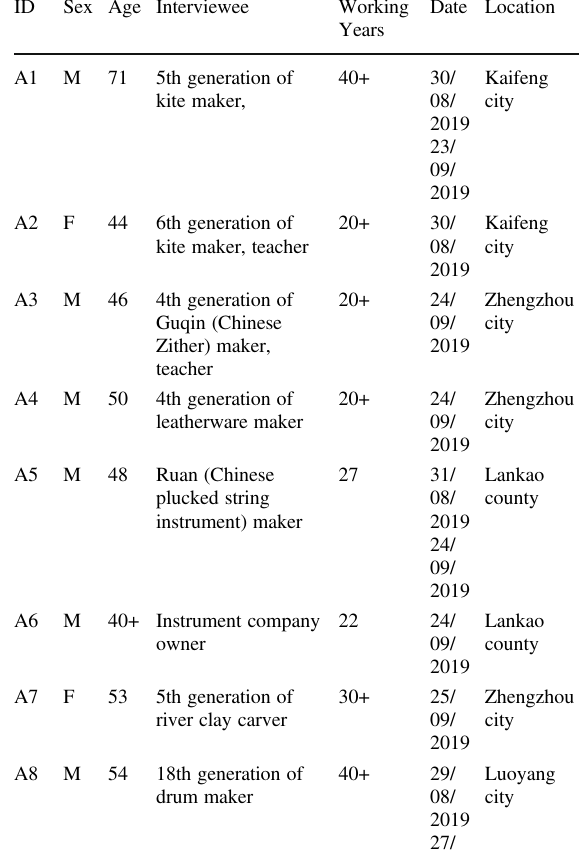
ID Sex Age Interviewee Working